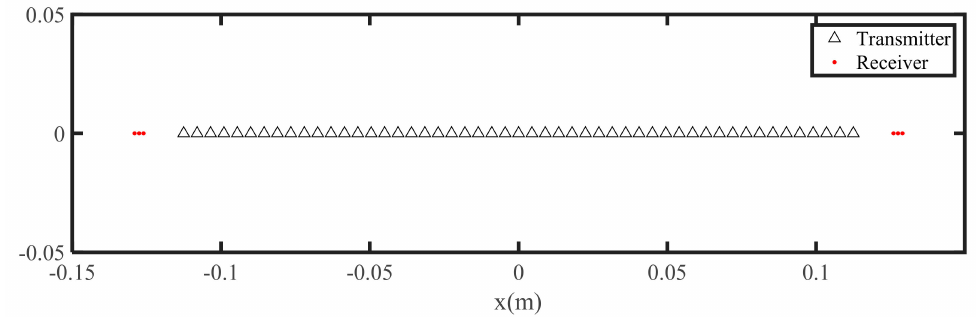
Figure 13. The equivalent MIMO array in